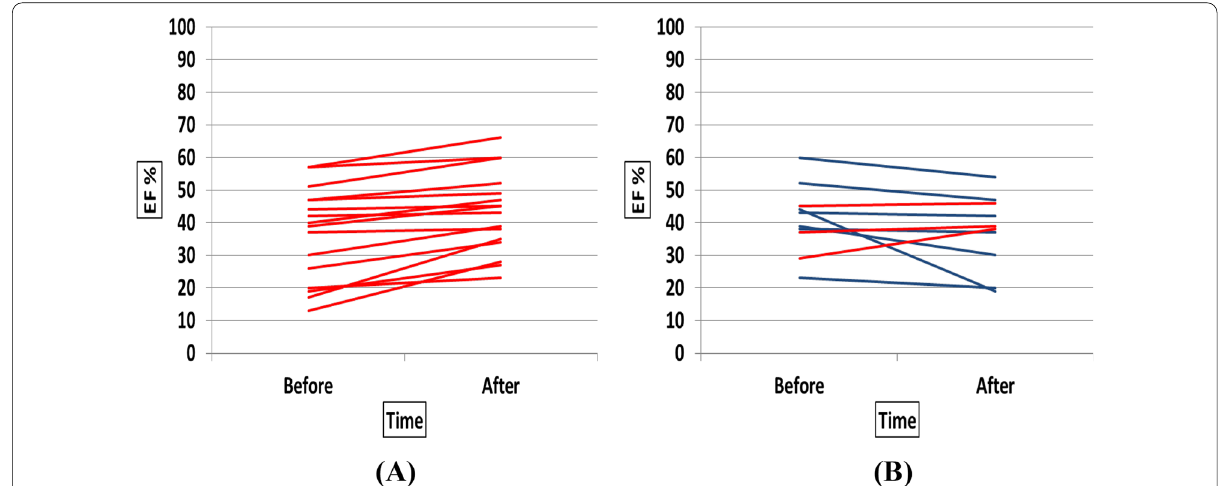
Fig. 1 EF in individual patients of TG ( A ) vs. CG ( B ) before and after the study (Red lines were for cases with improved